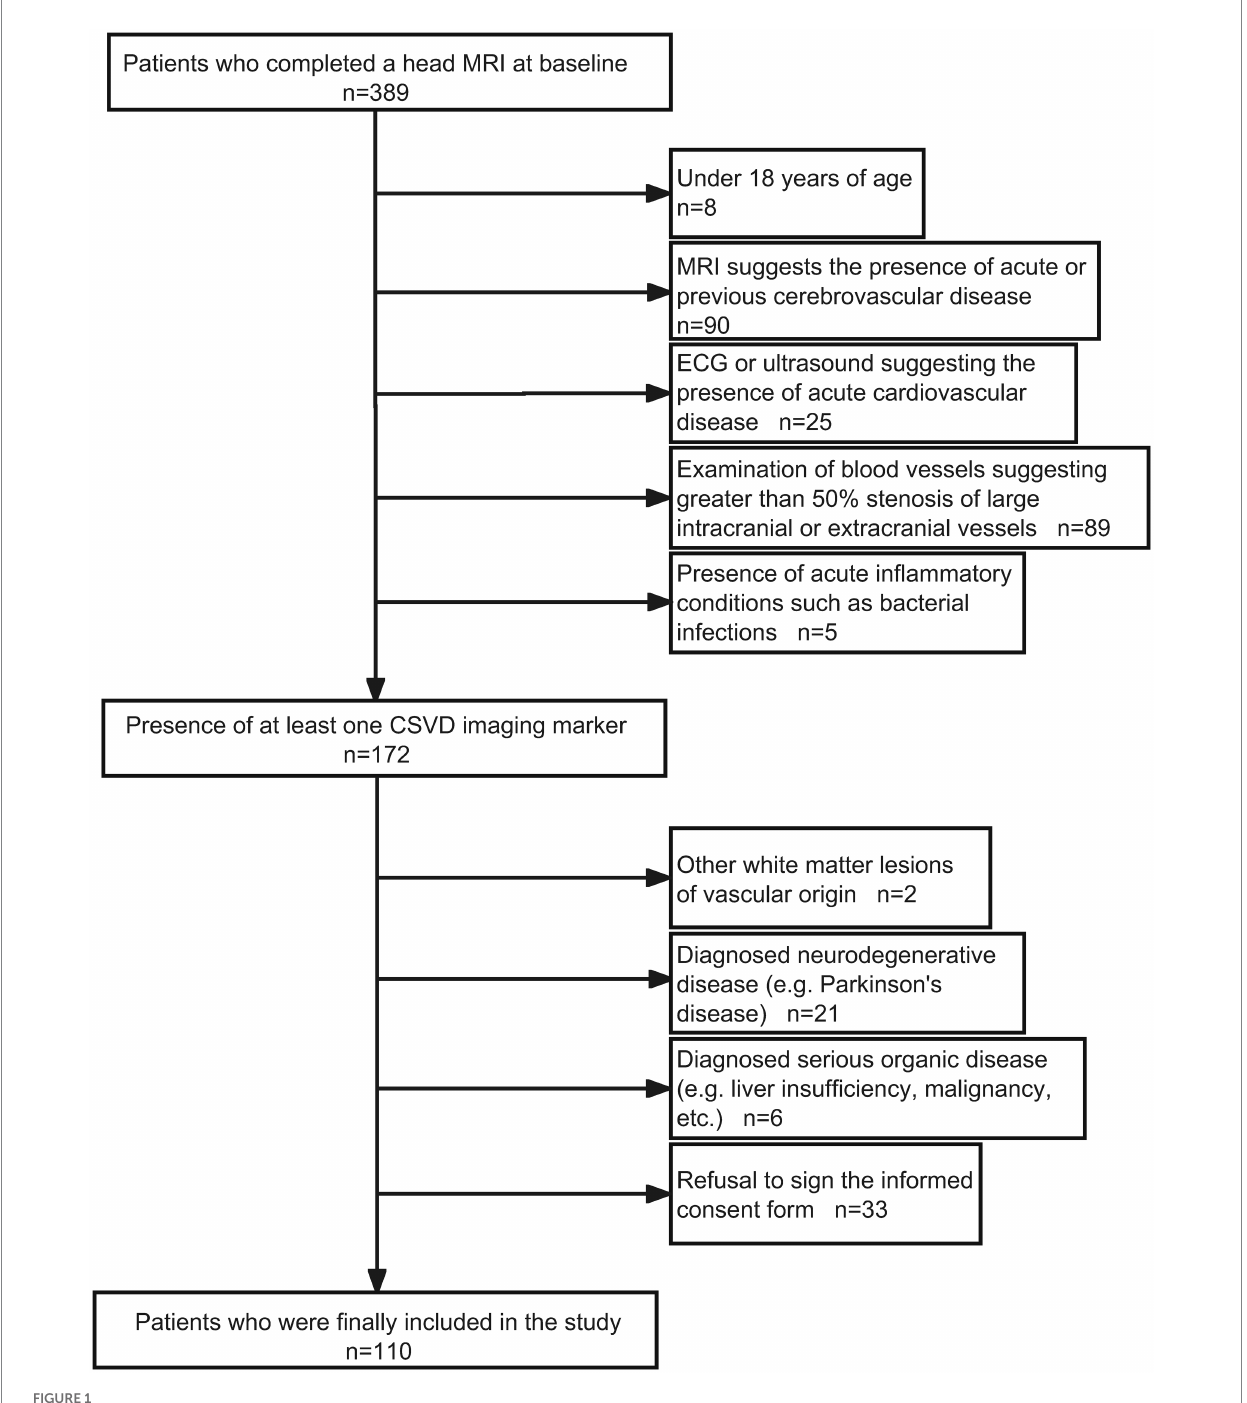
FIGURE 1 Admission flow